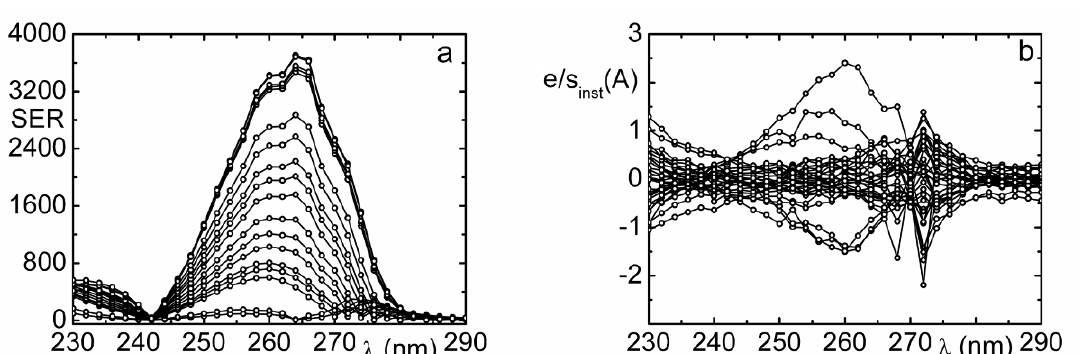
Figure 4. (a) The plot of small absorbance changes in the spectrum of risedronate means that the value of the absorbance difference for the j th-wavelength of the i th-spectrum Δ = A - A is divided by the instrumental standard deviation s ( A ), and the resulting ratios ij ij i, acid inst SER = Δ / s ( A ) are plotted depending on wavelength λ for all absorbance matrix elements, where A is the limiting spectrum i ,acid inst of the acid form of the drug measured. This ratio is compared with the limiting SER value for the risedronate to test if the absorbance changes are significantly larger than the instrumental noise. (b) The plot of the ratio e / s ( A ), i . e ., the ratio of the residuals divided inst by the instrumental standard deviation s ( A ) depending on wavelength λ for all the residual matrix elements for risedronate, tests inst if the residuals are of the same magnitude as the instrumental noise, (SPECFIT/32, Fig. 3e assists the detection of an outlier spectrum point, a trend in the spectrum residuals, or an abrupt shift of level in the spectra. The statistical measures of all the residuals from Fig. 2b prove that the minimum of the elliptic hyperparaboloid is reached: the mean residual e = 0.46 mAU and the residual standard deviation s ( e ) = 0.70 mAU have sufficiently low values. The skewness g ( e ) = 0.22 is close to zero and proves a symmetric 1 Gaussian distribution of the residuals set, while the kurtosis g ( e ) = 4.08 is close to 3 proving a Gaussian 2 distribution. The Hamilton R-factor of relative fit is 0.16% calculated with SQUAD(84) only, proving that an excellent fit is achieved, and the parameter estimates may therefore be considered reliable. If the Hamilton R-factor of relative fit, expressed as a percentage is < 0.5% the fit is excellent, but if it is > 2% the fit is poor. The criteria of resolution used for the hypotheses were: (1) a failure of the minimization process in a divergence or a cyclization; (2) an examination of the physical meaning of the estimated parameters to ensure that they were both realistic and positive; and (3) the residuals should be randomly distributed about the predicted regression spectrum, and systematic departures from randomness were taken to indicate that either the chemical model or the parameter estimates were unsatisfactory.